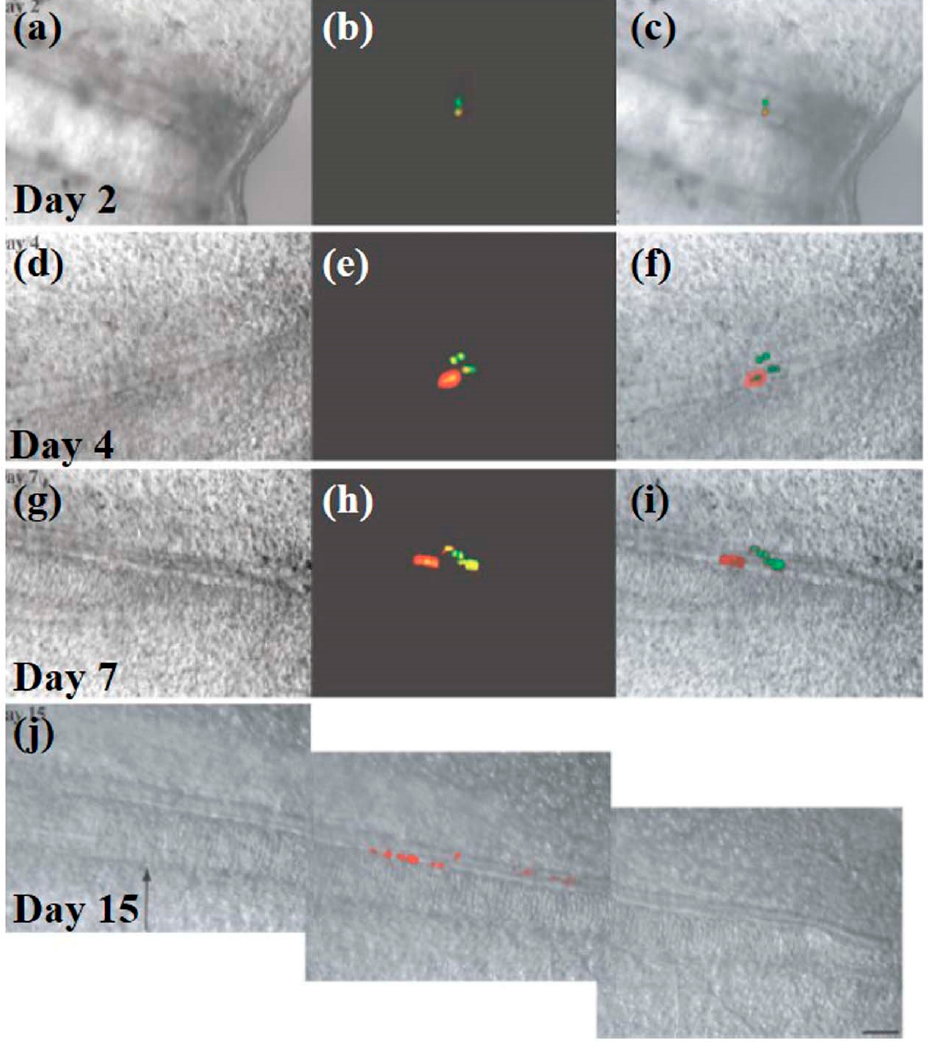
Figure 14. ( a – j ) Cell transfection is shown with cytoplasmic DsRed2-N1 and nuclear green fluorescent protein plasmids ( b , c ). The merged fluorescence and differential interference contrast (DIC) images after 2 days of amputation depict both the cells in the spinal cord with a distance of approximately 250–300 μ m from the amputation plane ( c ). In the next 2 days, the cells undergo division and recruitment to the regenerating spinal cord ( e , f ). (The panels show only regenerating tissue.) The cell division continues and spinal cord growth continues rapidly ( g – j ). ( j ) A composite image of DIC images merged with the fluorescent image (15 days). Here, the initial two cells give rise to approximately ten cells on both the dorsal and ventral sides of the midportion of the developing spinal cord. The cell group is present over 560 μ m length along the anterior/posterior axis. The original amputation plane is depicted by an arrow sign. Scale bar 100 μ m in ( j ) (applicable to a – j ). Reprinted with permission from [124]. Tanaka et al. performed single-cell electroporation and small interfering RNA (siRNA) delivery for gene silencing against the green fluorescent protein into GFP-expressing Golgi and Purkinje cells in cerebellar cell cultures. The temporal alterations in the GFP fluorescence (in the same electroporated cells) were observed for 4–14 days via repeated imaging (Figure 15). Furthermore, they checked